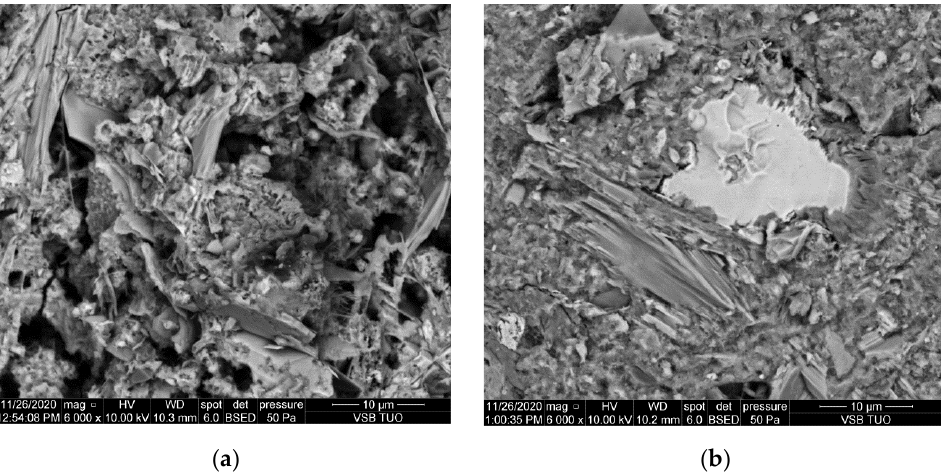
Figure 3. SEM images of the microareas of C.I.3 specimen: ( a ) Needle-like crystals of ettringite; ( b ) Platty crystals of portlandite.